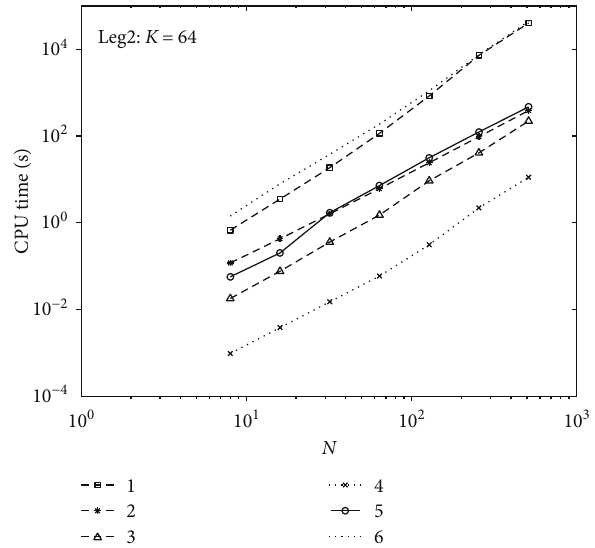
Figure 4: CPU times for the di ff erent steps in the forward problem for Leg2 with K = 64 sources: (1) solution of equation (5) for G ρ , ρ with CGFFT and “ marching on in angle ” ; (2) computation S ρ , ρ of the incident fi eld G ; (3) computation of the scattered 1 S fi eld G scat ρ , ρ ; (4) one CGFFT iteration; (5) the summation R S hom ρ , ρ (42) to obtain the total fi eld G . The curve (6) gives the cas S CPU time for step (1) with the incident fi eld as initial